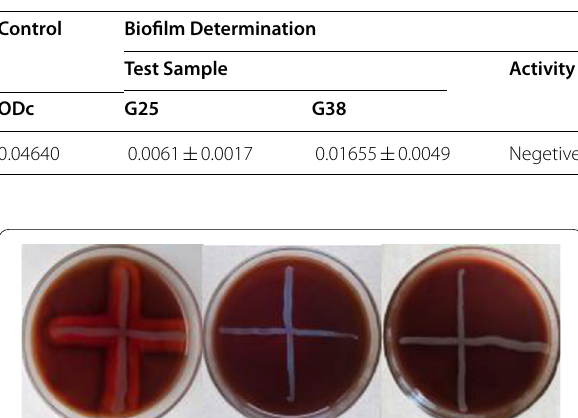
Table 3 Biofilm activity of BA degrading bacteria